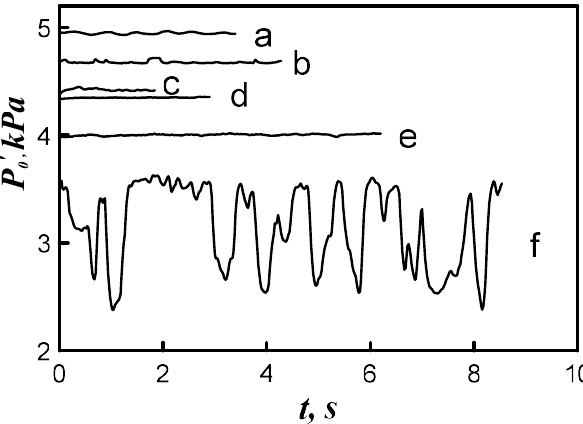
Figure 11. Time evolution of the pressure P 0 ' at the points ( a – f ) on the jet axis shown in Figure 10b.